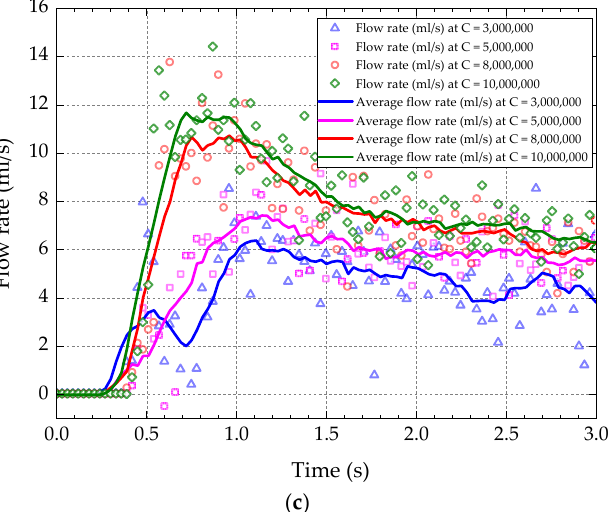
Figure 4. Resisting moment and flow rate–time curves against total cells: ( a ) resisting moment of rotor shaft; ( b ) resisting moment of bearing components; ( c ) flow rate and its 10-point moving average value (Monitoring Plane 2).